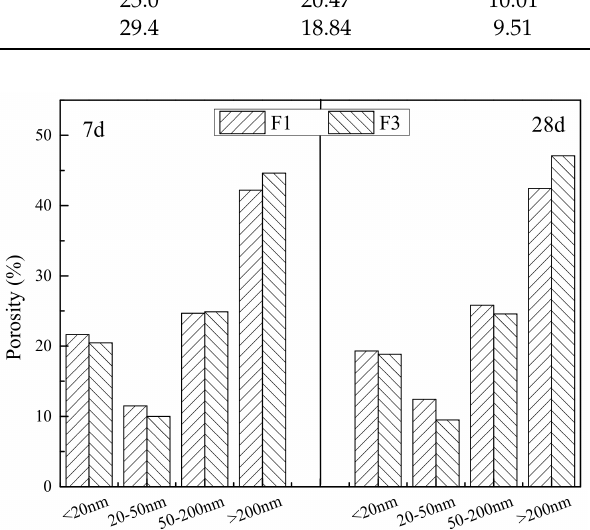
Figure 7. Pore structure parameters of filler at different ages of F1 and F3 groups.